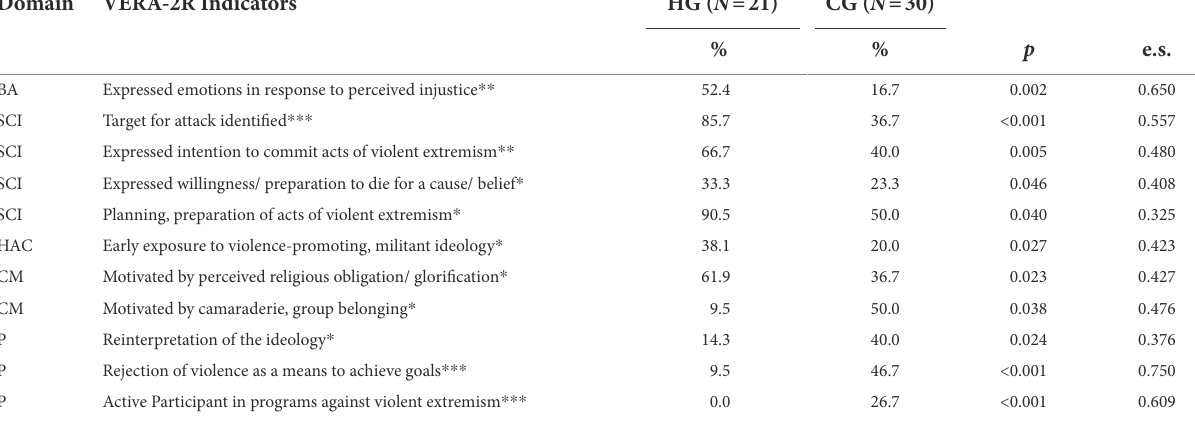
TABLE 8 VERA-2R Indicators positively or negatively associated with Jihadist homicide.